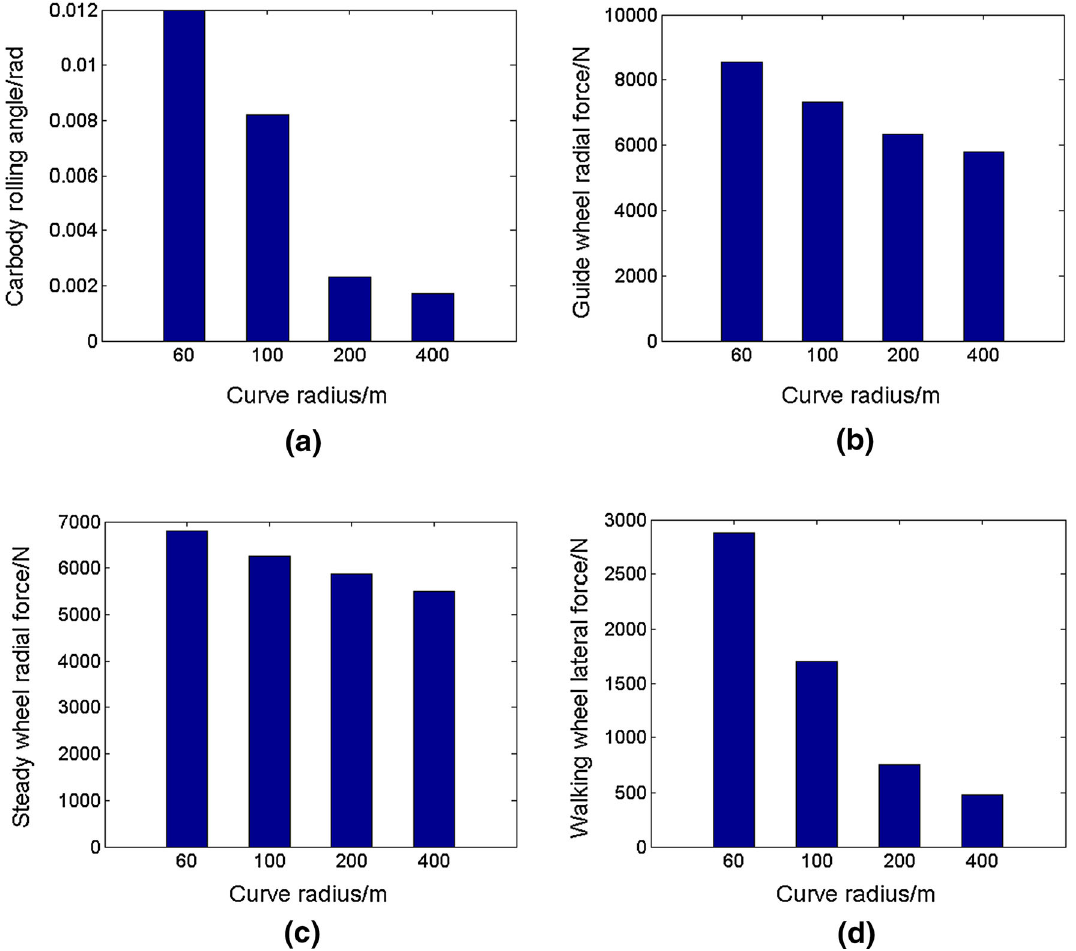
Fig. 9 Calculation results of curves with different radii, a carbody rolling angle, b guide wheel radial force, c steady wheel radial force, d walking wheel lateral